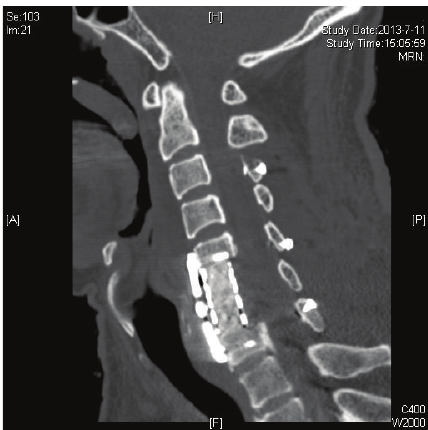
Figure 6: Postoperative CT-scan sagittal reconstruction. A C3– C7 laminoplasty and C6 corpectomy with reconstruction using a titanium mesh cage and plate has been done. The spinal canal is patent.